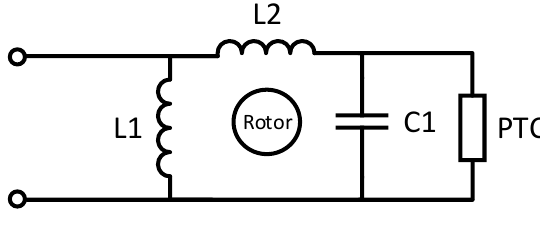
Figure 11. The schematic of freezer